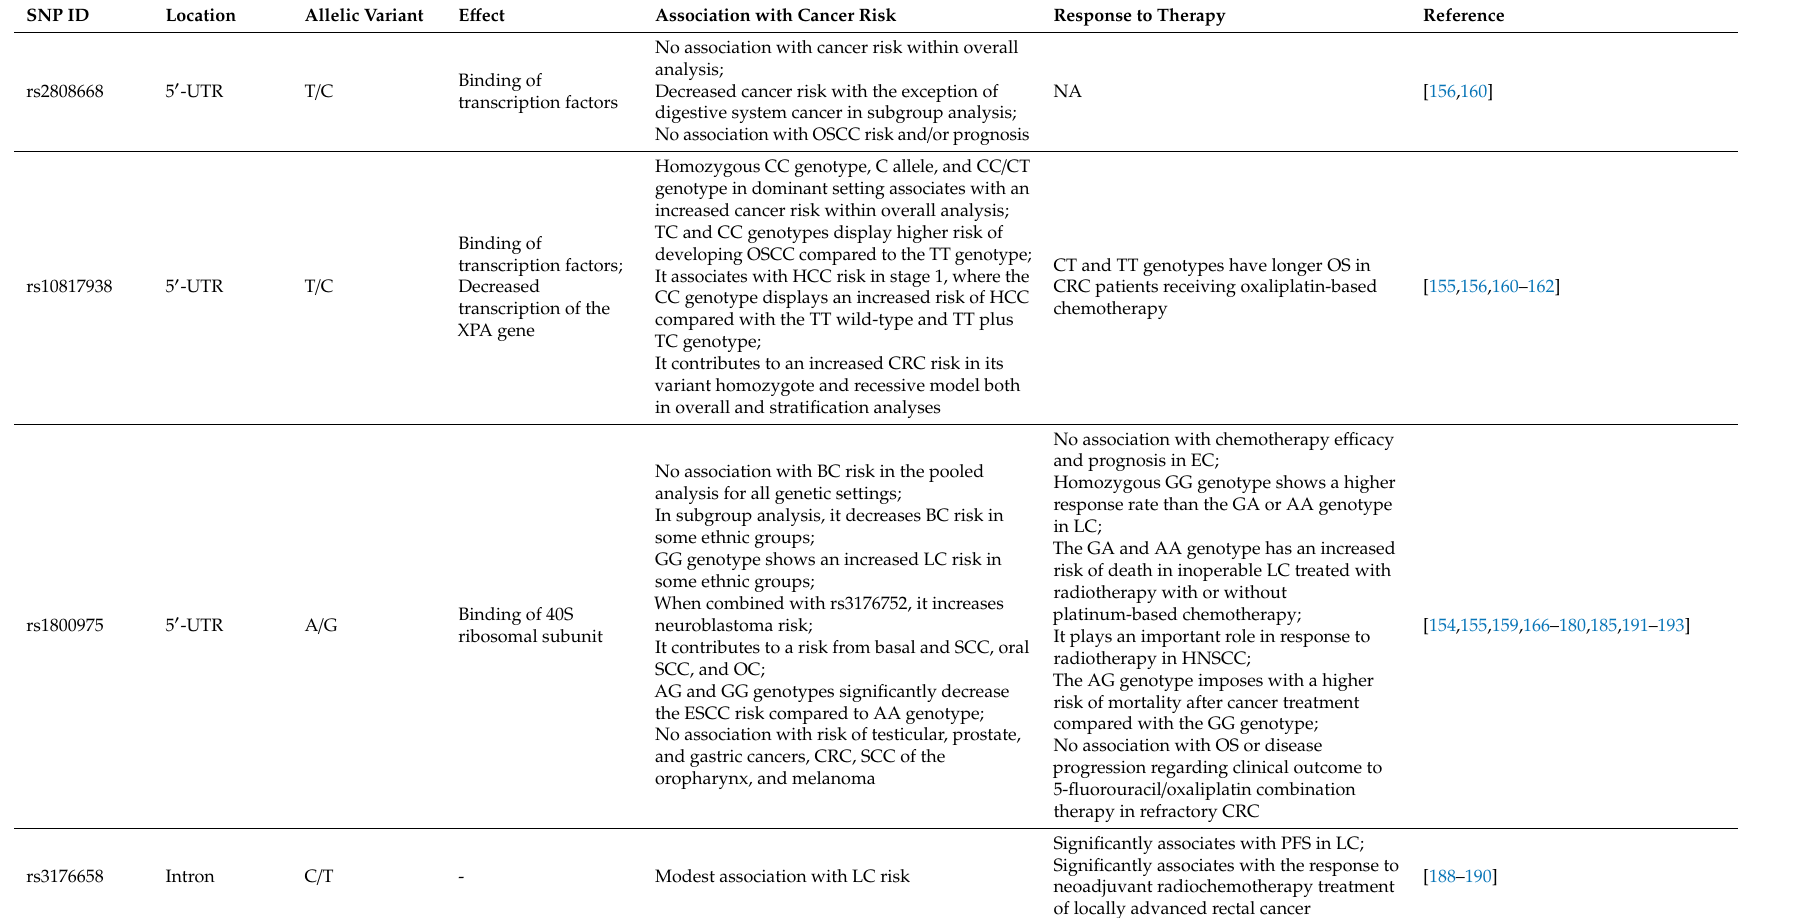
Table 1. XPA SNPs and their cancer